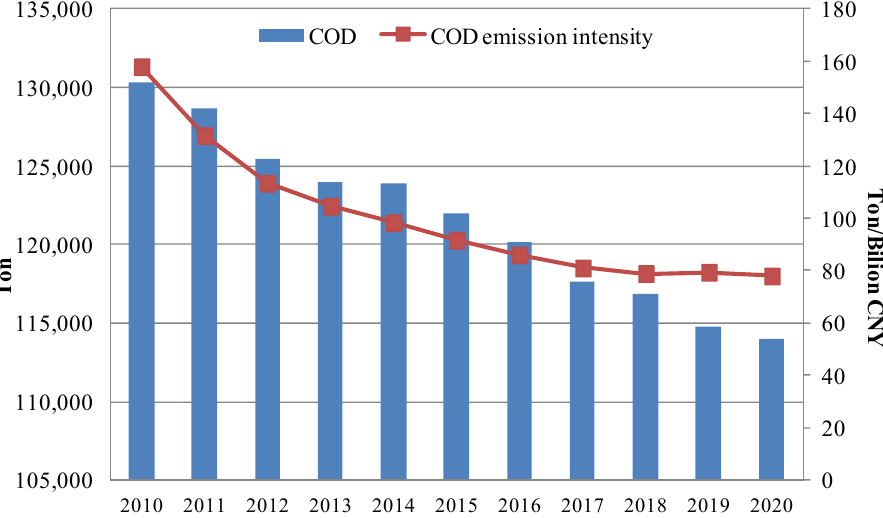
Figure 6. Water pollutants emission and intensity estimates from 2010 to